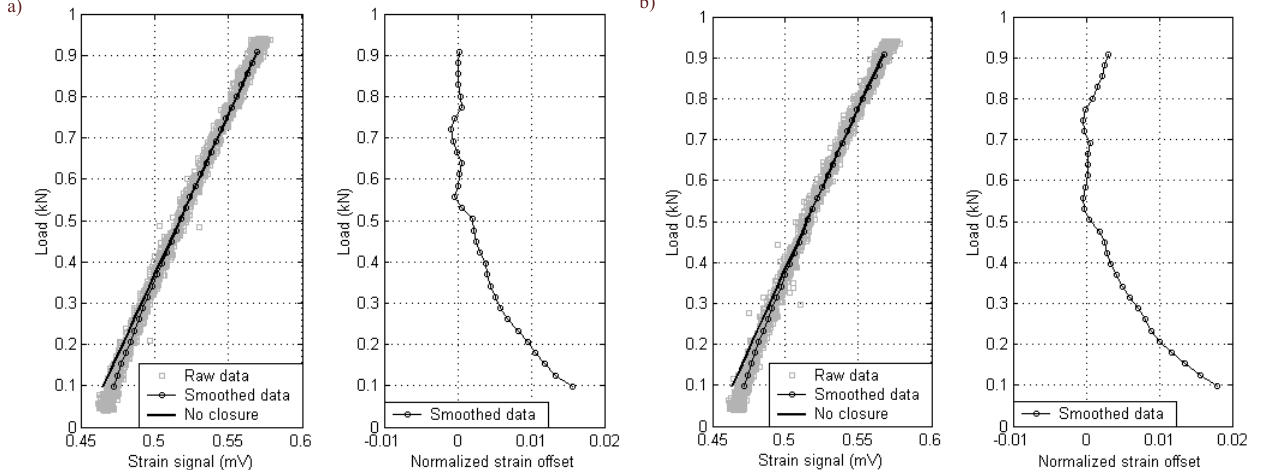
Figure 6: Illustration showing load vs. strain and load vs. strain-offset plots for a 42 mm crack in an aluminium CT specimen loaded between 0.94 and 0.04 kN (R-ratio 0.04). a) Unloading branch. b) Loading branch.